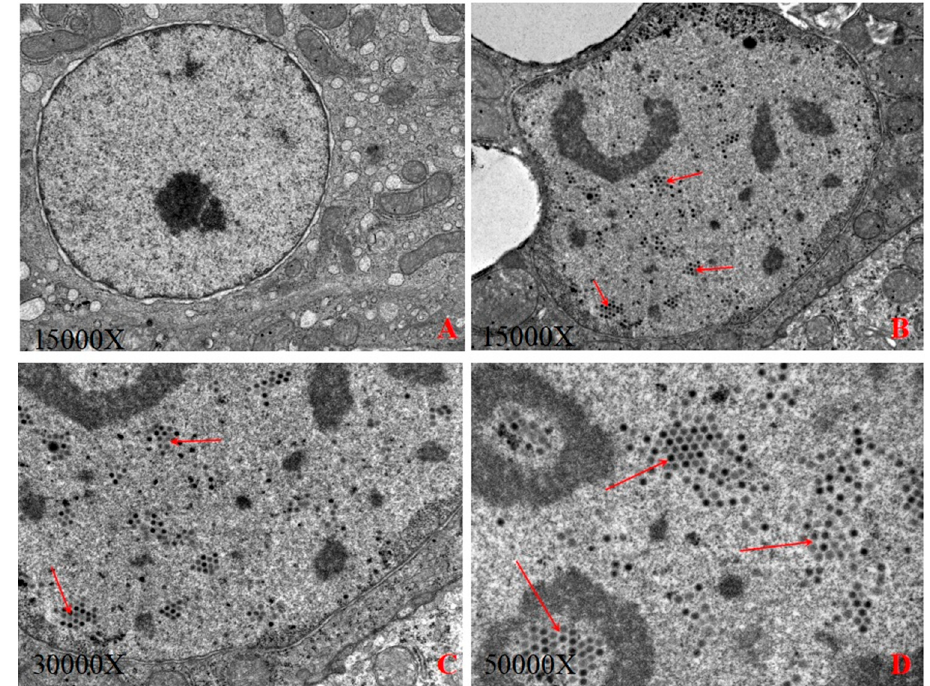
Figure 1. ( A ): The control group; ( B ): The virion of FAdV-4-SDJN0105 at 15,000× magnification; ( C ): The virion of FAdV-4-SDJN0105 at 30,000× magnification; ( D ): The virion of FAdV-4-SDJN0105 at 50,000× magnification.